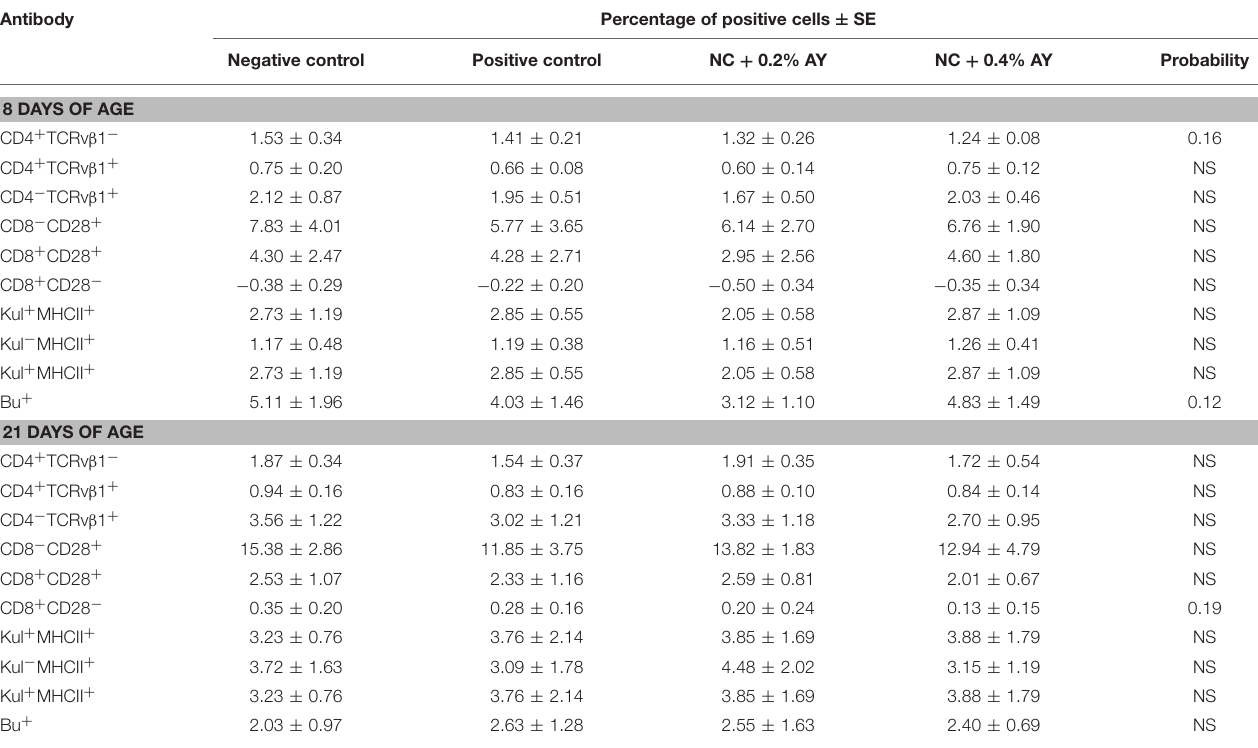
TABLE 6 | Percentages of identified subpopulations of circulating blood cells of broiler chickens supplemented with zinc bacitracin or autolyzed yeast of Saccharomyces cerevisiae . Antibody